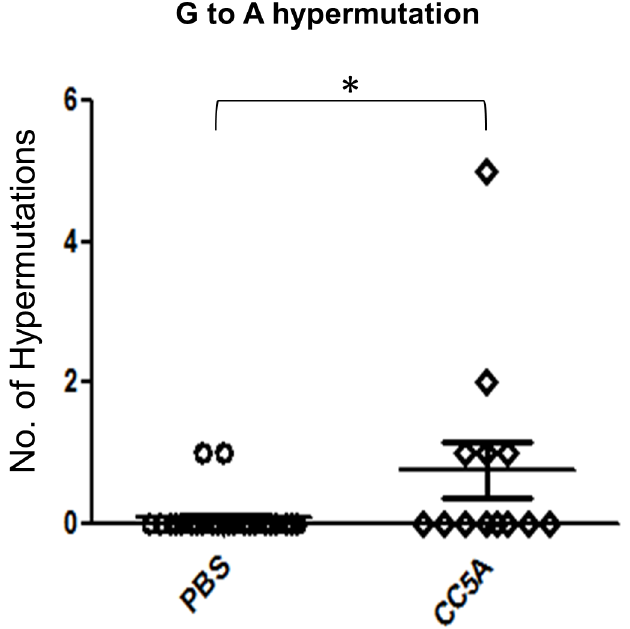
Figure 6. CC5A enhances HIV G to A hypermutation rate. HIV from CC5A or PBS treated THP-1 culture supernatants were used to infect SupT1 cells. The infected SupT1 cells were washed twice with PBS then incubated at 37 u C, 5% CO2 for 16 h. HIV cDNA was isolated using DNeasy DNA isolation kit (Qiagen). A 650 bp DNA fragment covering a portion of nef, U3 and R of HIV-1 was amplified by PCR. The PCR products were cloned into the TOPO TA-cloning vector. The nucleotide sequences of individual clones from each infected culture sample were determined. Statistical significance was determined by Mann Whitney U test using GraphPad Prism software. Mann Whitney U test was used to calculate p-value.